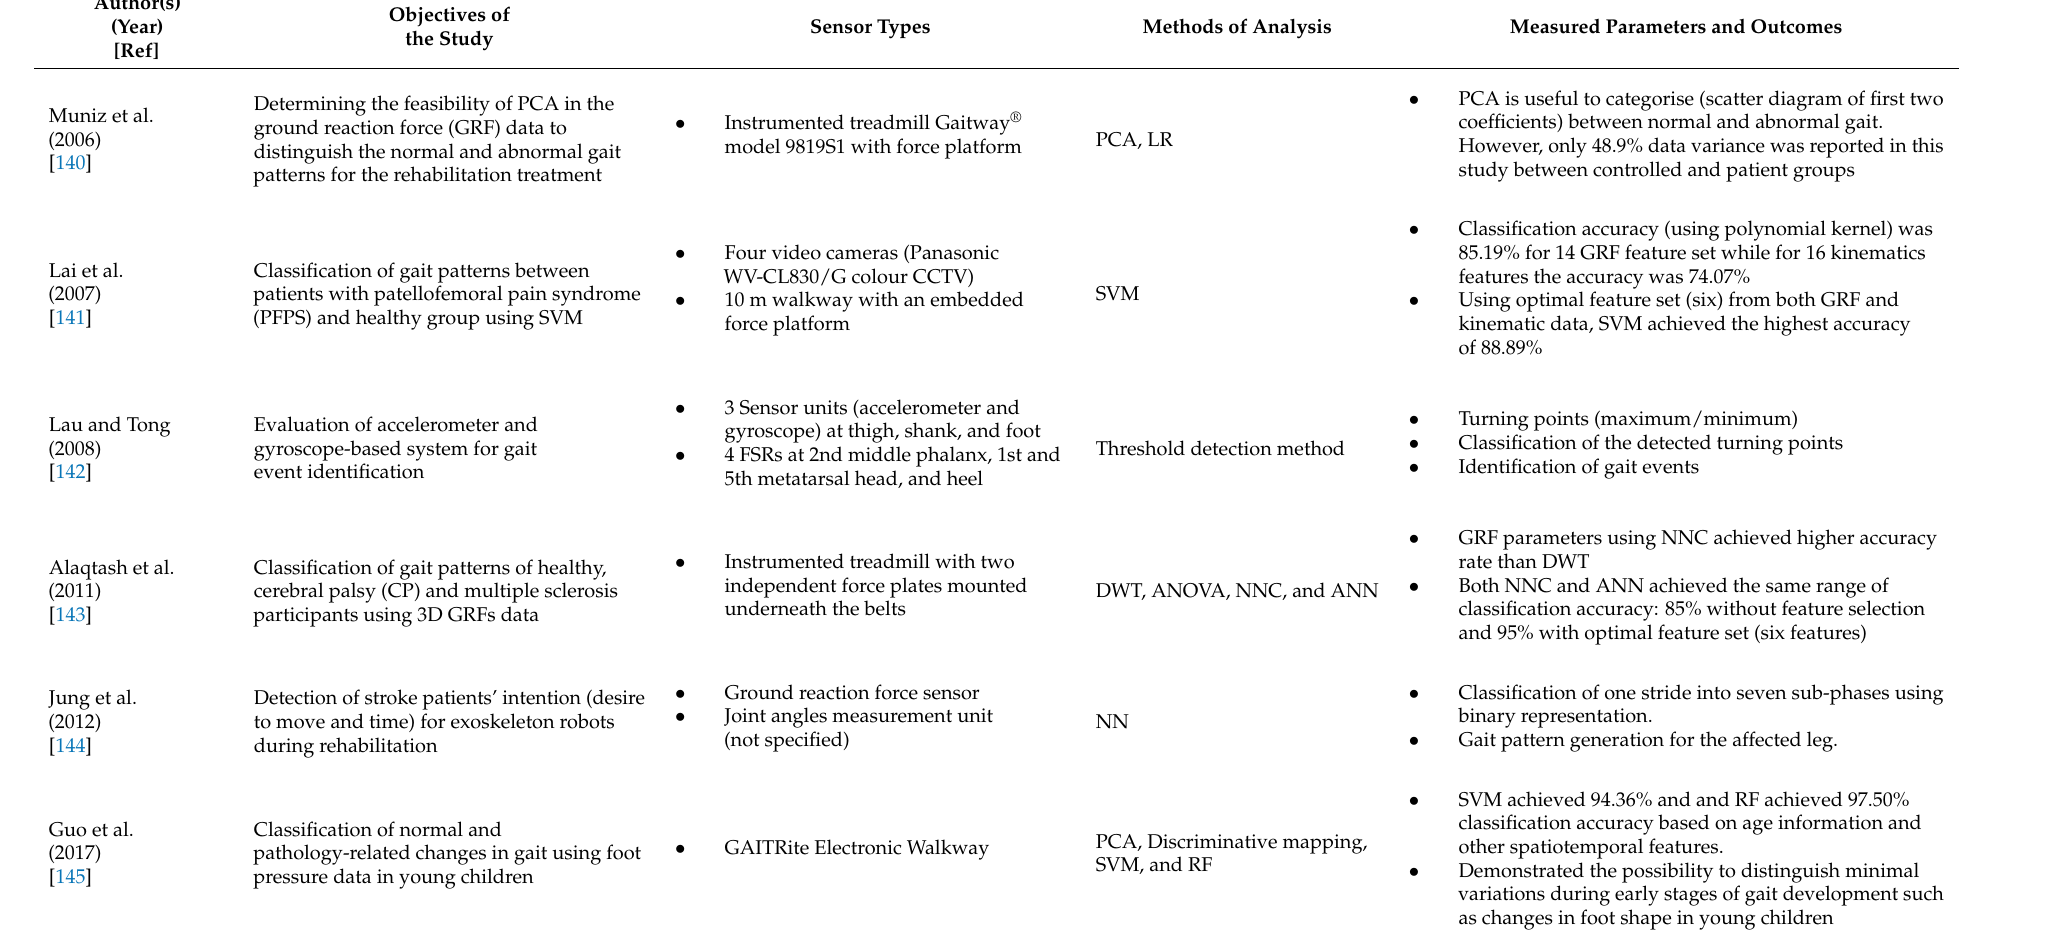
Table 5. Key points pertaining to various activity and gait analysis systems using advanced machine learning